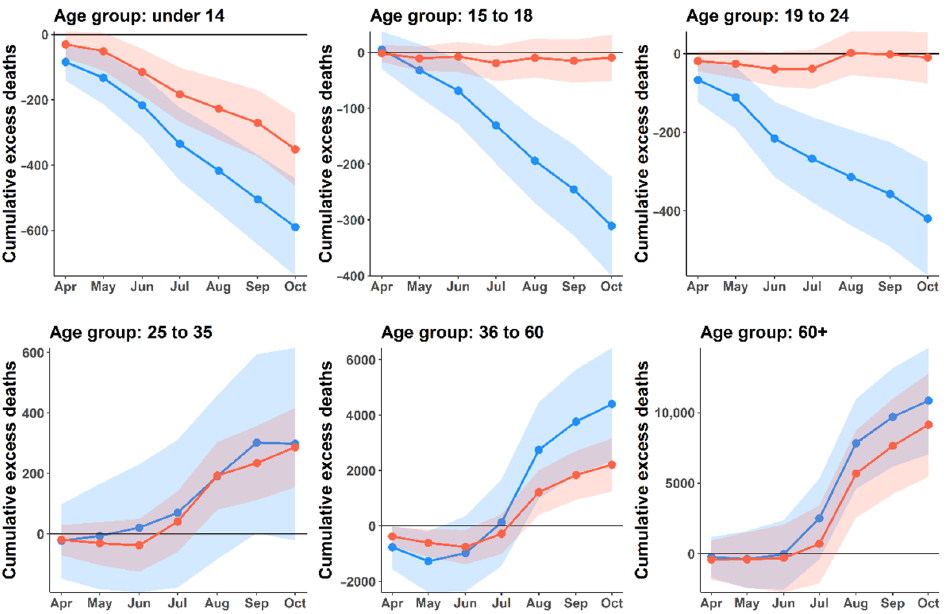
Figure 4. Cumulative excess deaths by gender and age groups . Lines illustrate the cumulative excess deaths by gender and age groups. Blue and orange lines represent men and women, respectively. deaths by gender and age groups . Blue and orange lines represent men and women, respectively . Shaded areas indicate the 95% prediction Shaded areas indicate the 95 % prediction intervals .